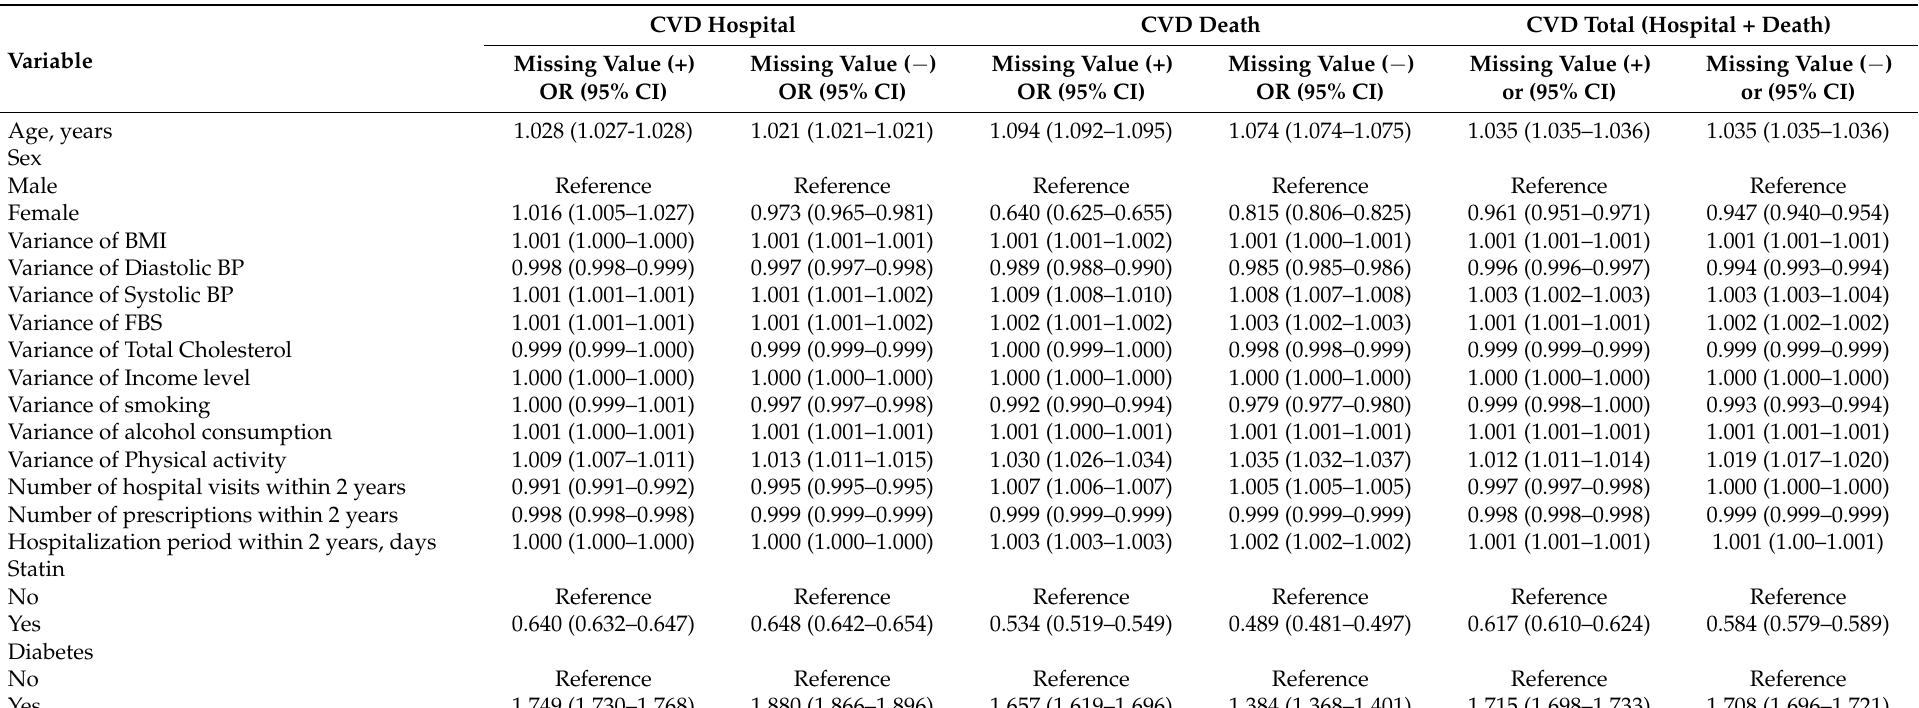
Table 2. Results of multiple logistic